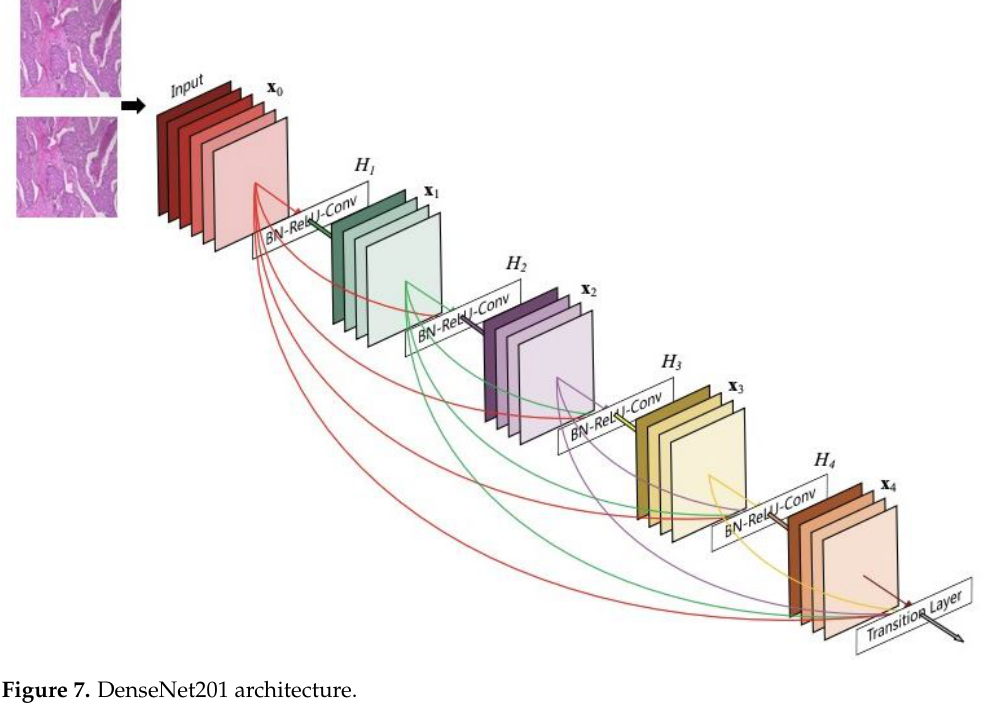
Figure 7. DenseNet201